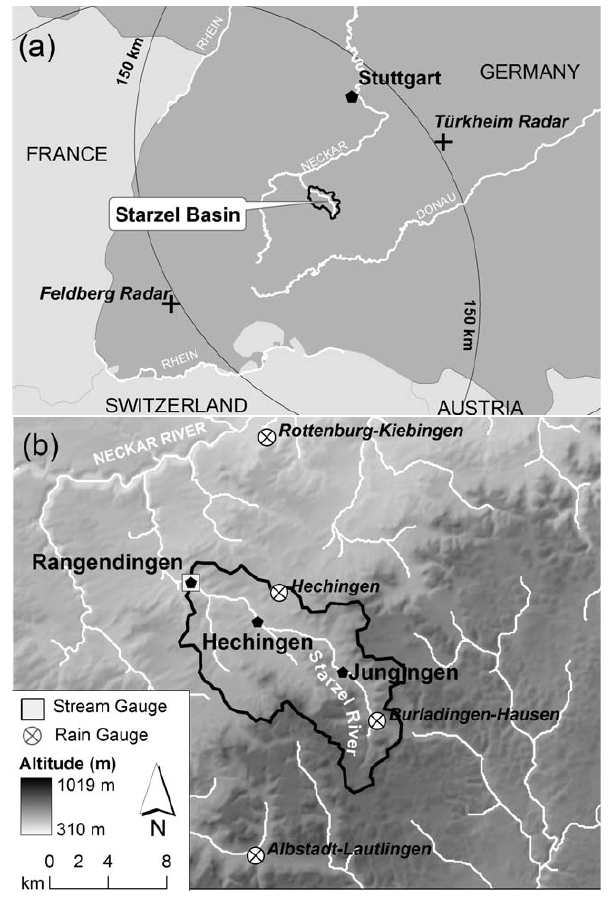
Fig. 1. (a) Location of the Starzel basin with the two weather radars, Türkheim and Feldberg (crosses) and corresponding 150km range circles; (b) the basin with orography and the location of the four raingauge stations and of the streamgauge.